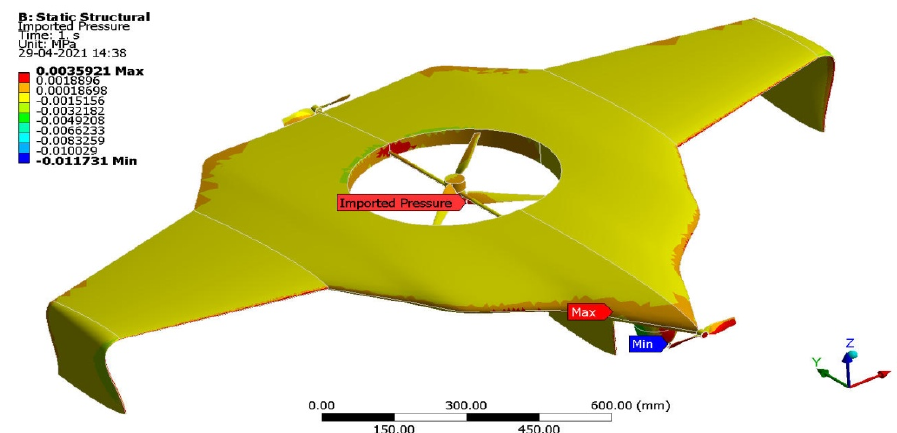
Figure 5. Aerodynamic loads imported for Version II.